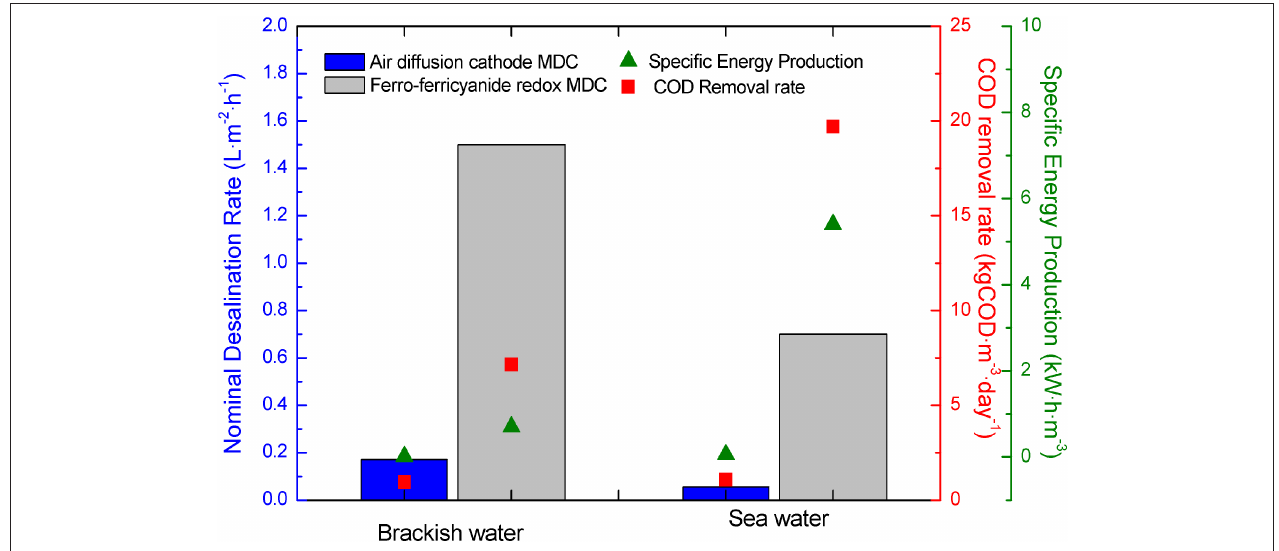
FIGURE 5 | Nominal desalination rate (NDR) (bar plot), COD removal rate (black line), and specific energy production (SEP) (green line) for both MDC strategies.